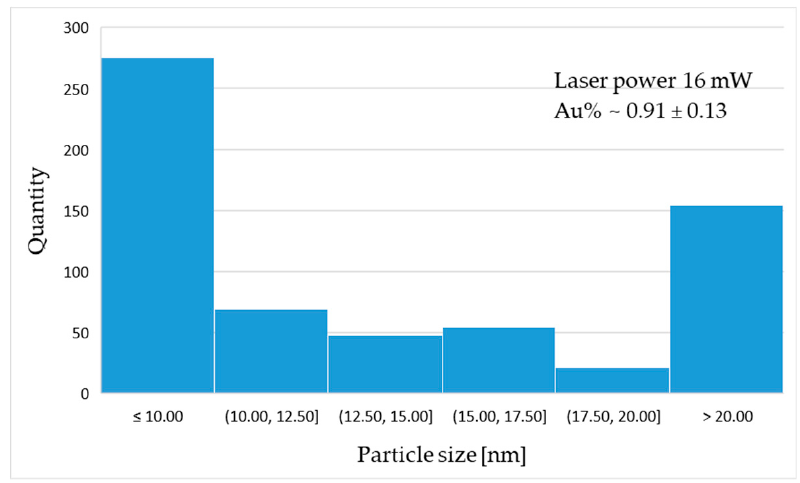
Figure 8. Histograms of particle distribution for sample: ( a ) 4 mW; ( b ) 15 mW; ( c ) 16 mW.